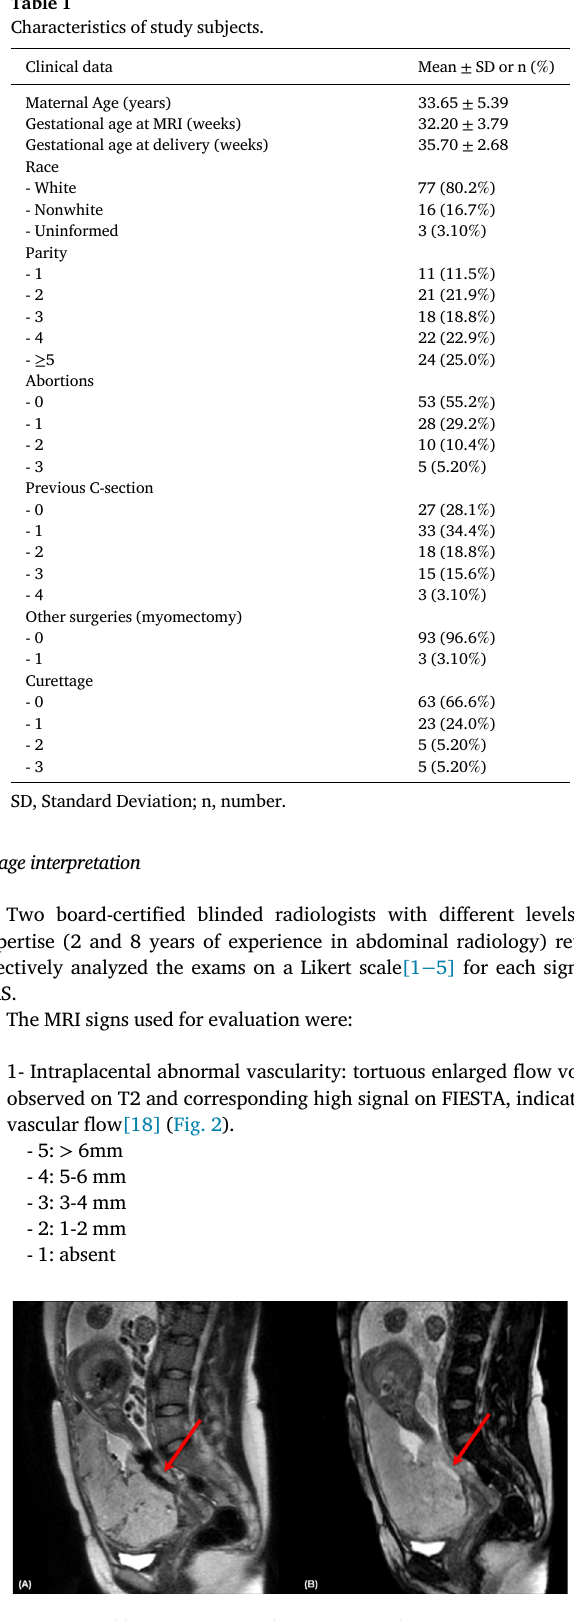
Fig. 2. 28-year-old woman at 34 weeks ' gestation with two previous C-sections. (A) Sagittal T2 weighted image shows intraplacental abnormal vascularity with a fl ow void in the placenta (arrow), and on (B) axial FIESTA there is a high signal on the structure indicating the presence of vascular fl